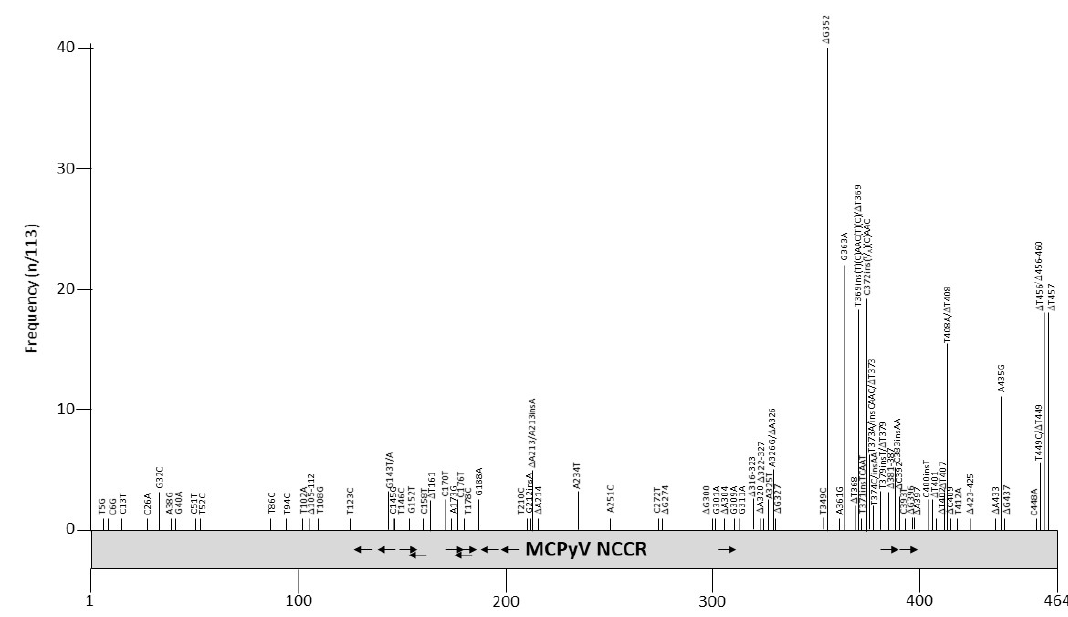
Figure 4. Mutations and their prevalence in variants of Merkel cell polyomavirus (MCPyV) noncoding control region (NCCR). The numbering of the NCCR is from early to late with nucleotide 1